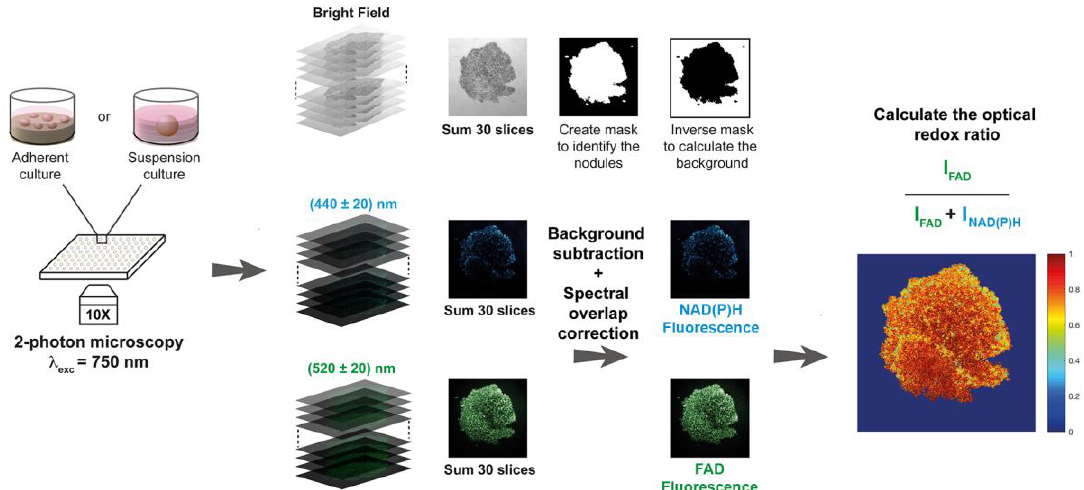
Figure 1. Schematic representation of the workflow for image acquisition and subsequent analysis (NAD(P)H = reduced nicotinamide dinucleotide (phosphate), FAD = flavin adenine dinucleotide). Image acquisition was performed using a multiphoton laser scanning microscope delivering a 750-nm excitation (alternatively, a single-photon excitation (405 nm) may be used [18] on a confocal set-up). A z-stack of 30 images (0.1 µ m step-size) was measured to increase the signal-to-noise ratio while preventing photothermal e ff ects. The image analysis procedure firstly summed the images within the z-stack. Bright-field images were used to highlight the individual spheroids / microtumors using a binary mask, of which the inverse was used to determine the median background fluorescence intensities. Background was subtracted from the summed fluorescence images, after which the redox ratio was calculated on a pixel-by-pixel basis. Median redox ratios and redox ratio heatmaps were used as primary outputs.